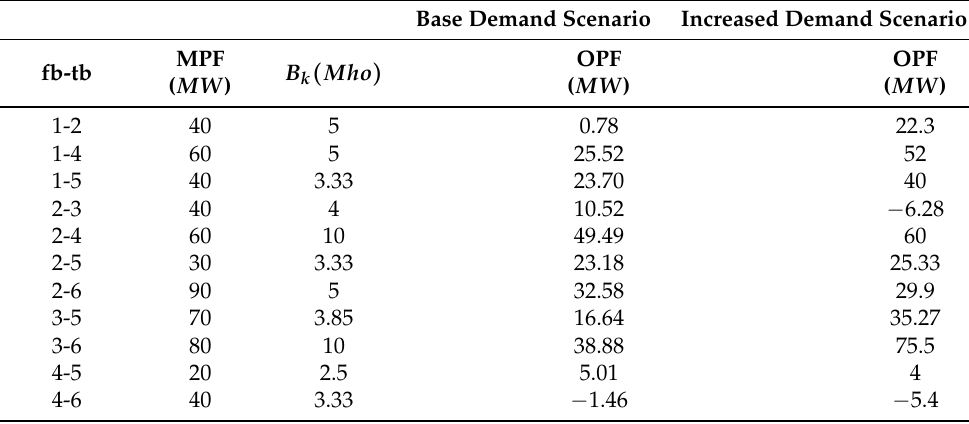
Table 3. The results of the optimal power flow of the 6-bus system with increase in